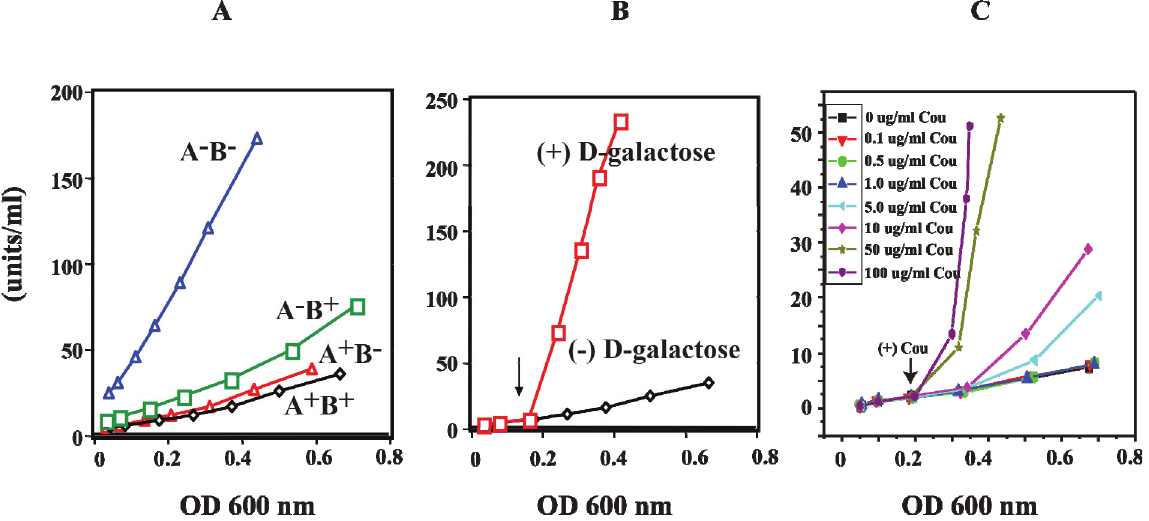
Figure 13. Effect of HU and D -galactose on P2 in vivo . ( A ) (cid:7)-glucuronidase activity as a reporter of the P2 promoter in WT ( hup A + B + ) and mutants ( hup A + B (cid:2) , hup A (cid:2) B + and hup A (cid:2) B (cid:2) ) strains; ( B ) (cid:7)-glucuronidase activity from P2 in WT ( hup A + B + ) strain in the absence and presence of D -galactose; ( C ) (cid:7)-glucuronidase activity from P2 in WT ( hup A + B + ) strain in the presence of various coumermycin concentrations. The arrow indicates